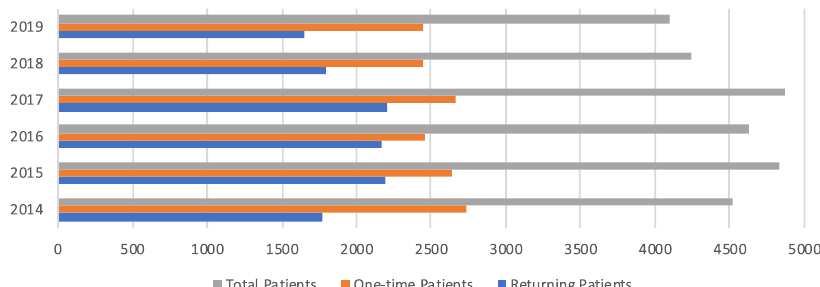
Fig. 2 Trends of Mobile-Mammogram utilization over time. These numbers include total participants, one time participants, and returning